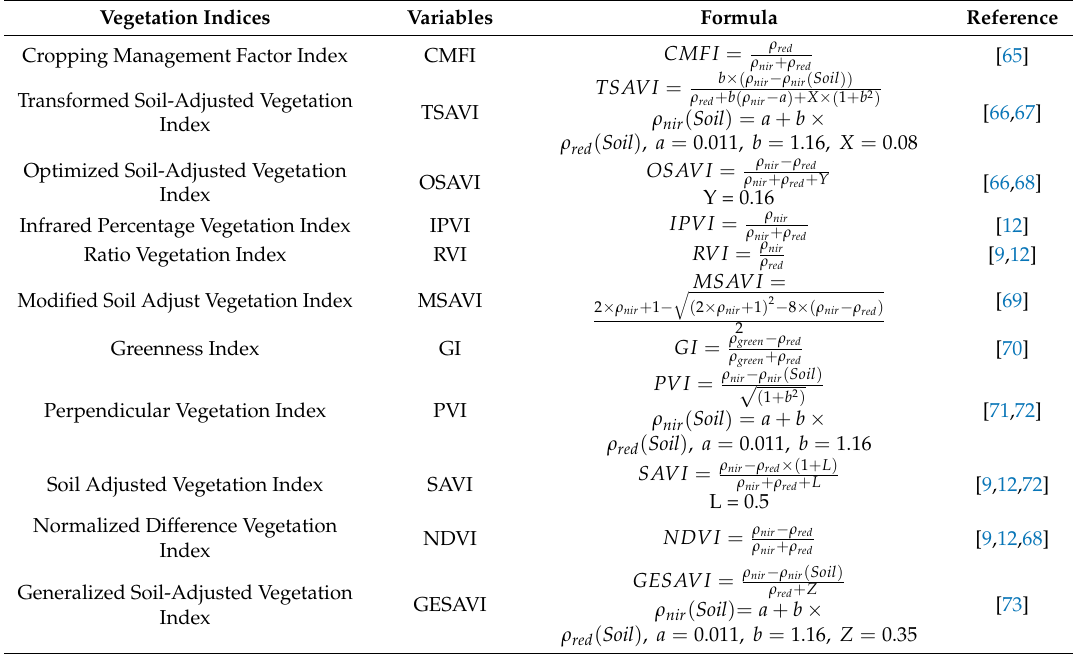
Table 1. Vegetation indices used for rice yield